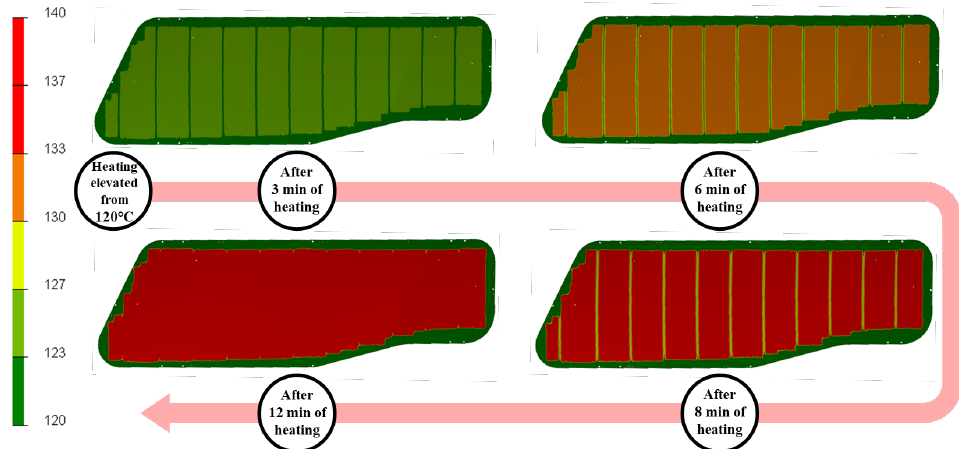
Figure 10: Preheating stages for the composite tool before resin injection.